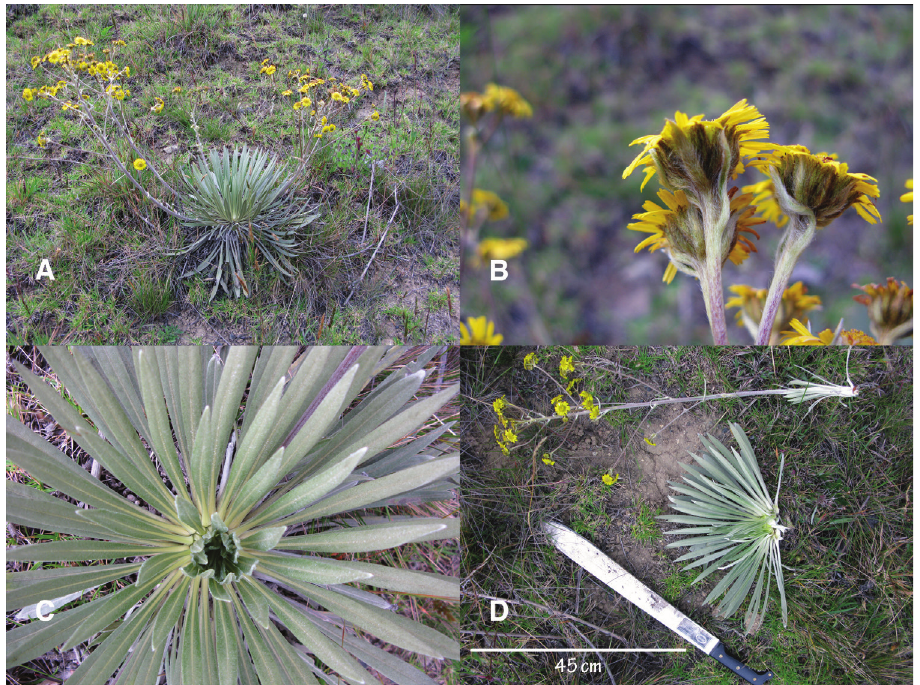
Figure 5. Espeletiopsis santanderensis : A acaulescent (sessile) habit B lateral view of a section of the capit- ulescence, showing the long peduncles of the capitula C rosette from the top D capitulescence spreading and rosette ( M. Diazgranados 3841